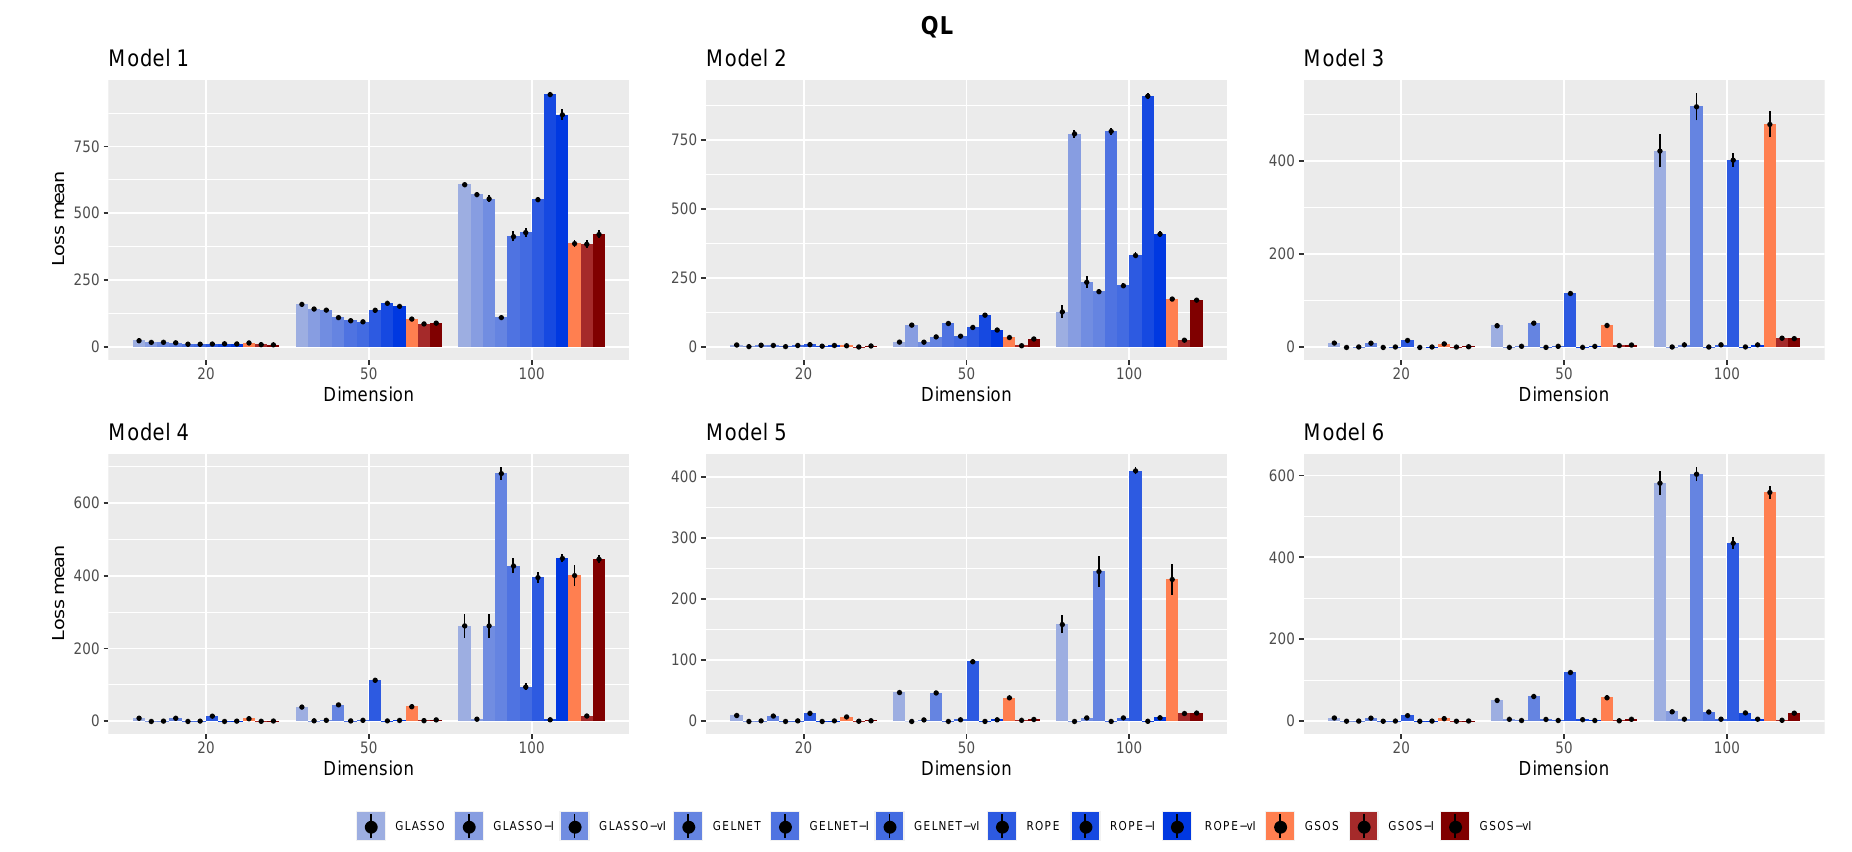
Figure 3. The mean of quadratic loss for the different models and methods based on 100